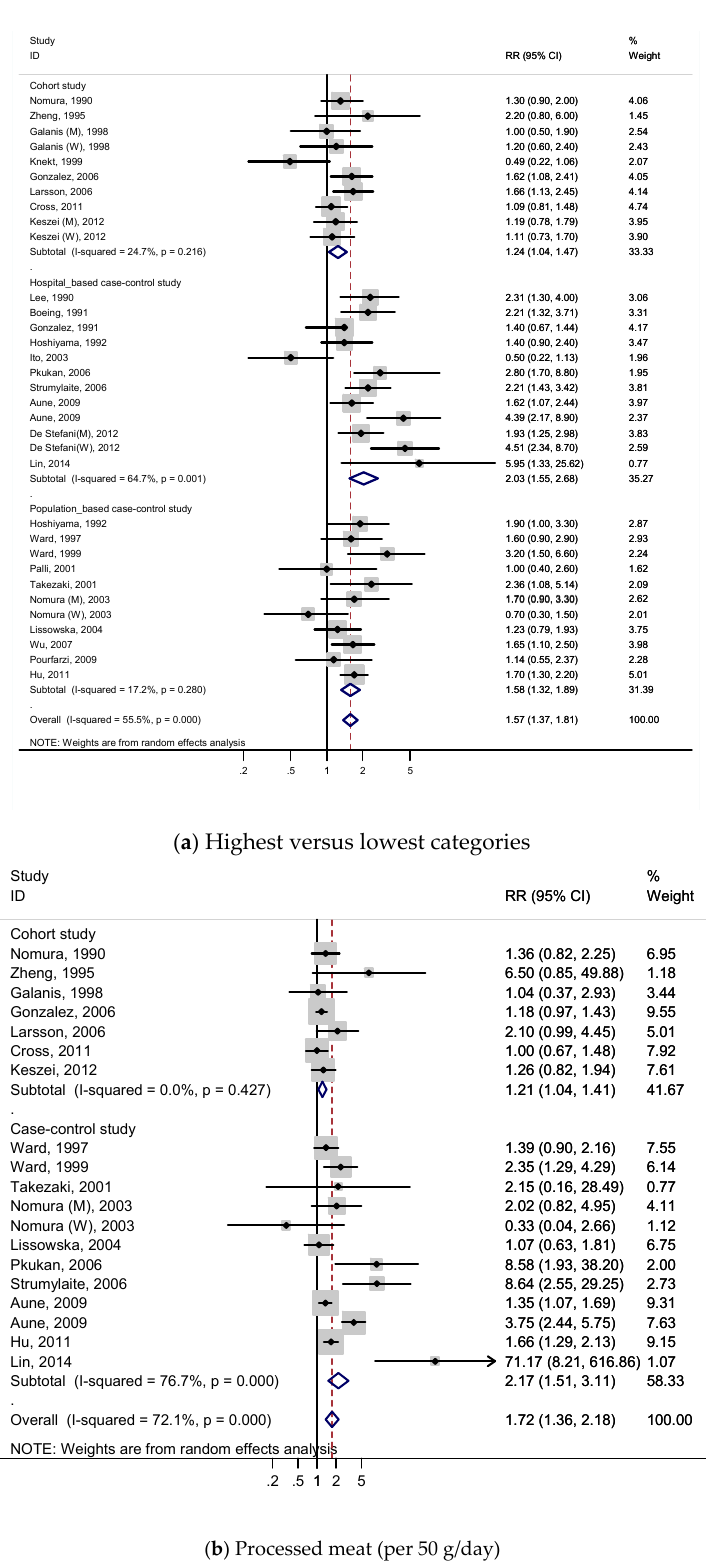
Figure 3. Adjusted relative risks and 95% confidence intervals of gastric cancer for processed meat consumption. Squares indicate each study’s relative risks. Horizontal lines indicate 95% confidence intervals. Diamonds indicate the summary relative risks and 95% confidence intervals. ( a ) Highest versus lowest categories of processed meat consumption; ( b ) dose–response meta-analysis for 50g/day increase in processed meat consumption.